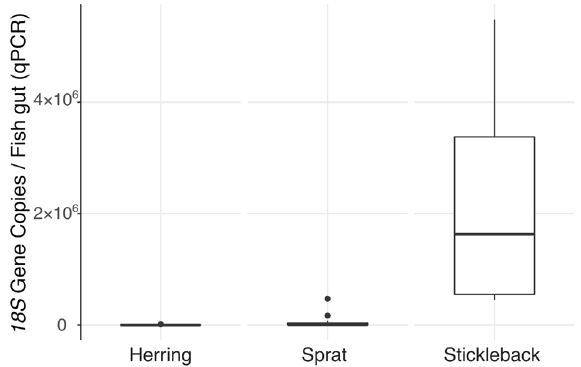
Figure 3. Quantitative PCR assay of rotifers in the gut content of the planktivorous fish sprat, herring and stickleback in the southern Baltic Sea targeted by rotifer-specific 18S rRNA gene primers. The results are shown as equivalents to rotifers 18S gene copies.